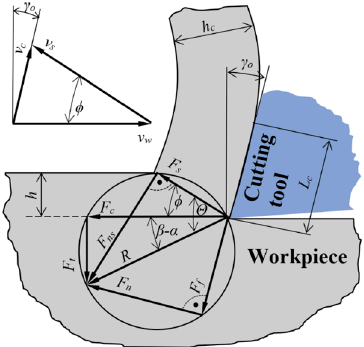
Figure 1. Force and velocity components in Merchant´s model.